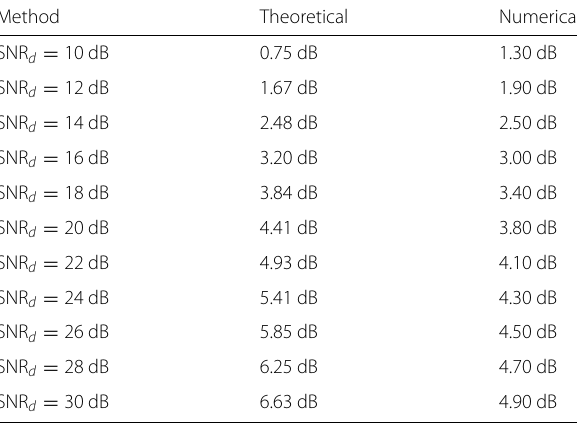
Table 1 Results of the numerical and theoretical optimal IBOs as a function of the SNR d used in Fig. 6